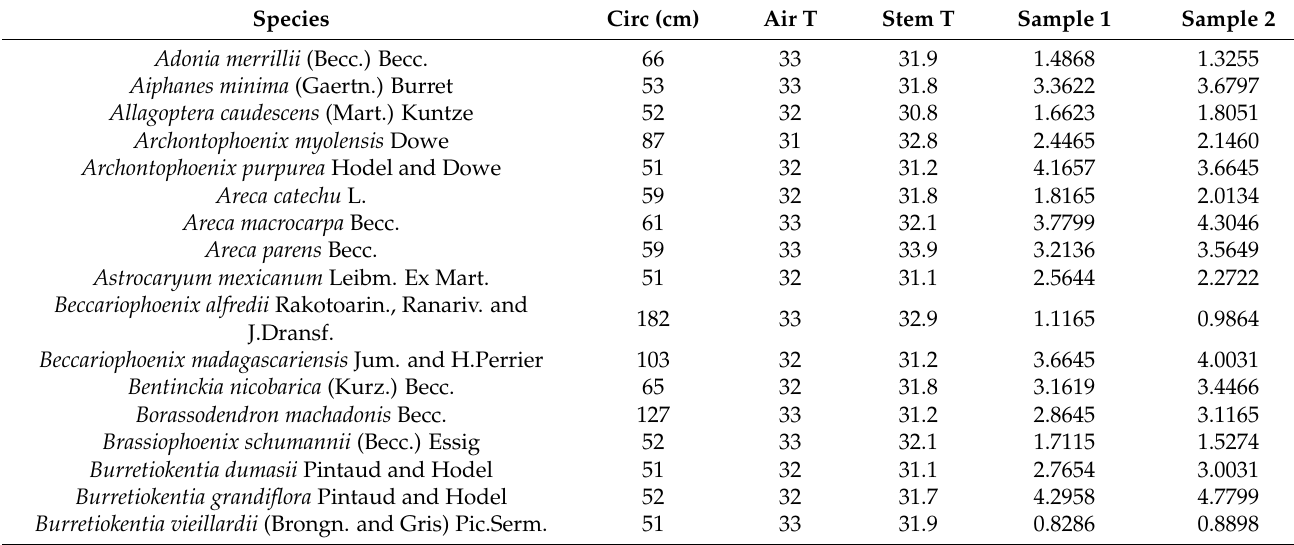
Table A4. List of the Arecaceae species included in the carbon dioxide efflux study. Circ = circumfer- ence, Air T = air temperature, and Stem T = surface temperature of stems.